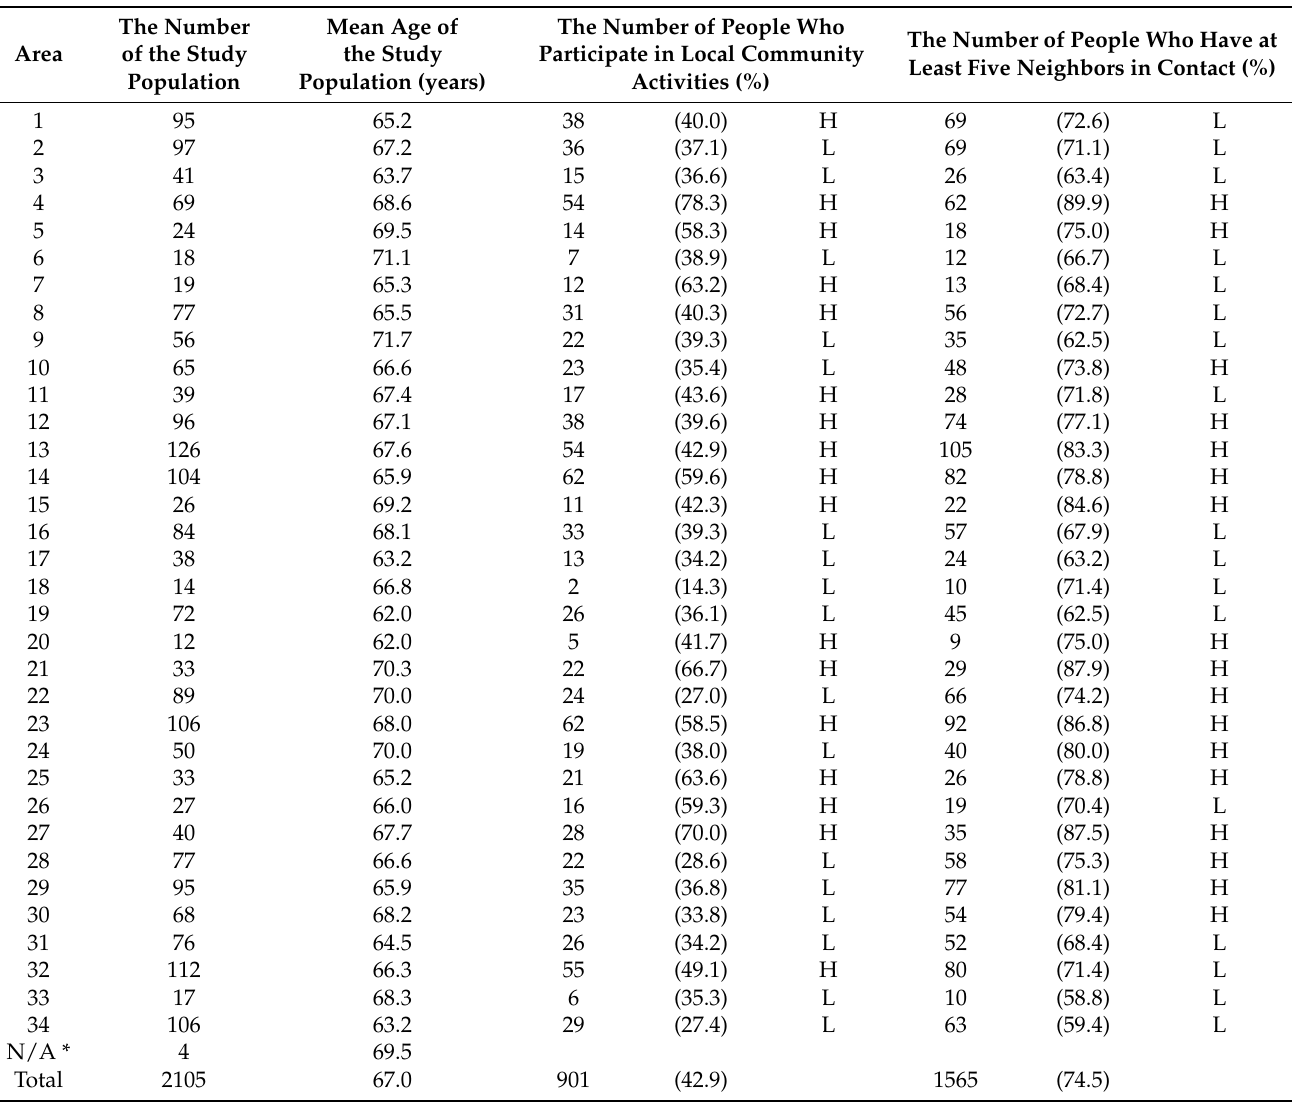
Table A1. The characteristics of town areas (at the time of the baseline